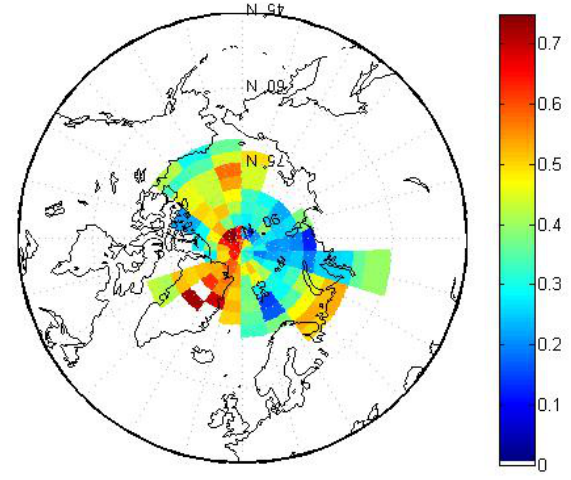
Fig. 11. PSCF analysis of the Continental